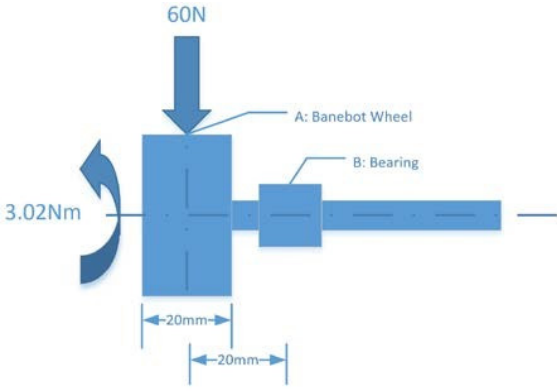
Figure 5. Motor shaft combined bending and twisting moment.